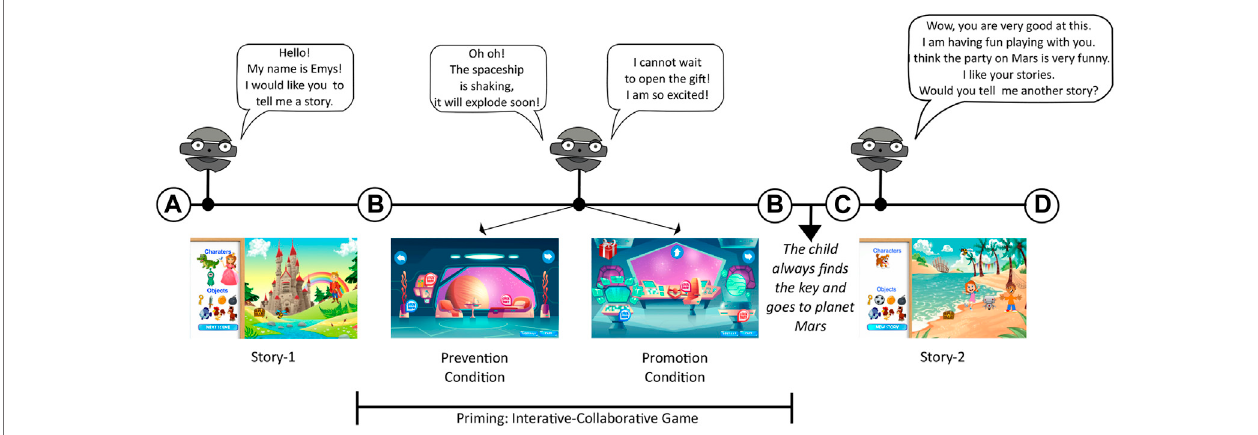
FIGURE1| Flowoftheinteractive – collaborativeactivity. (A) Story-1,thechildtellsthe fi rststorytotherobot. (B) PrimingGame,thechildandtherobotplayagoal- oriented game. The game has two versions: prevention and promotion. In both versions, the child always achieves the goal. (C) Story-2, the child tells a second story to the robot. (D) Questionnaires. Note: in this article, we only focus on the “ priming ” part of the activity.